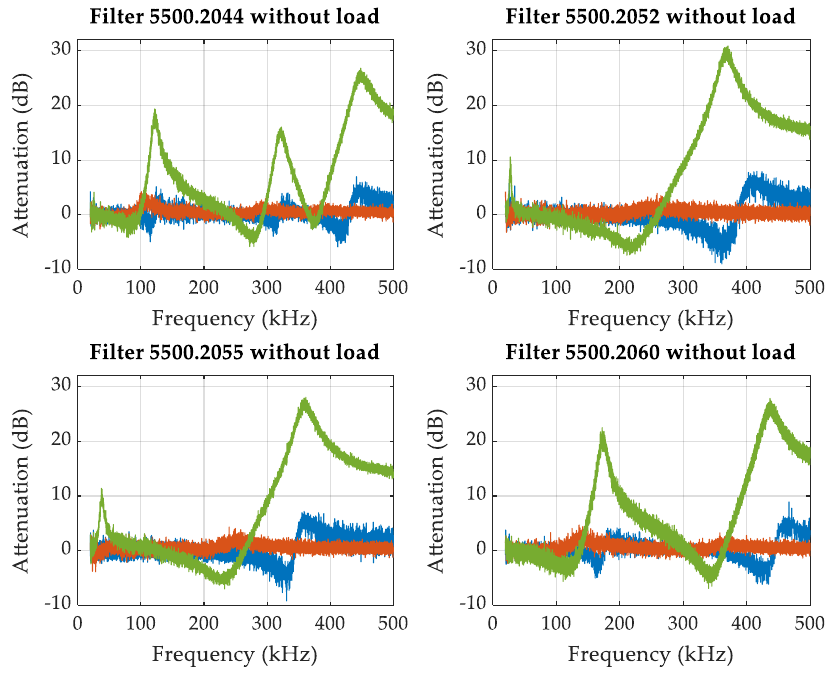
Figure 7. Attenuation due to the EMC filters under study in an open-circuit configuration. Blue lines indicate that the filter is connected at point A, red lines indicate connection point B, and green lines indicate connection point C.